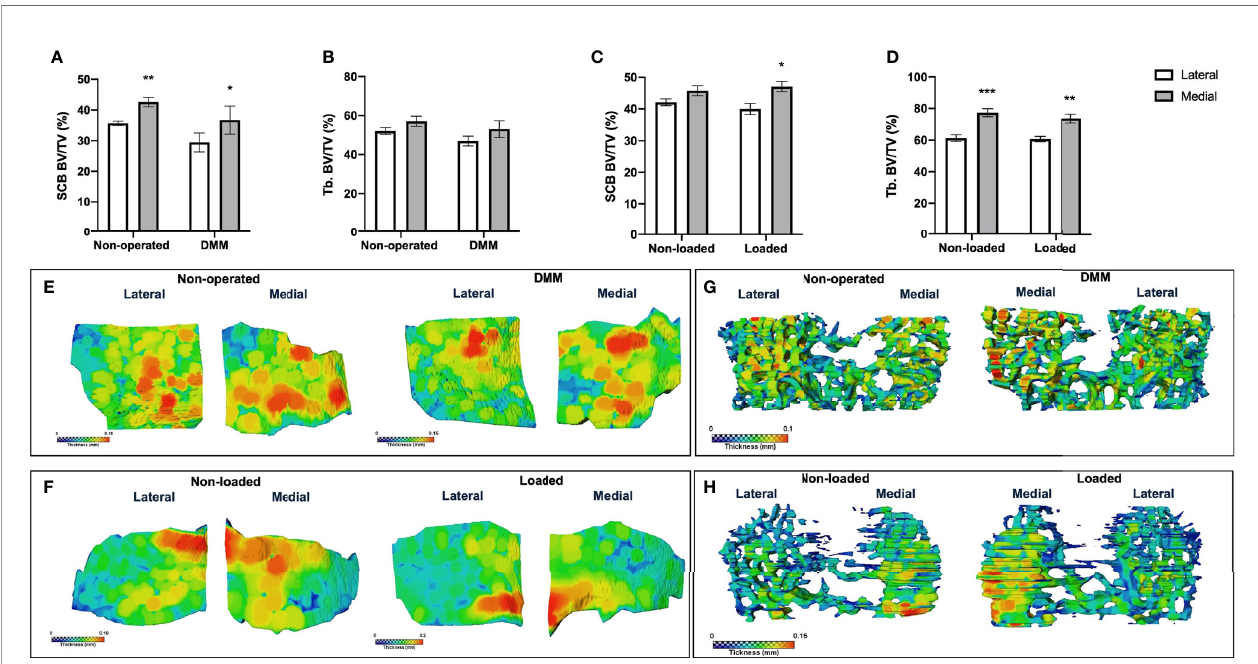
FIGURE 4 | MicroCT analysis of epiphyseal region of medial and lateral tibiae of mice. MicroCT analysis of the epiphyseal region of the lateral and medial tibiae in non-operated controls and DMM-operated knee joints subchondral bone volume fraction (SCB BV/TV) (A) and epiphyseal trabecular bone volume fraction (Tb. BV/ TV) (B) . MicroCT analysis of the epiphyseal region of the medial and lateral tibiae in non-loaded controls and loaded knee joints subchondral bone volume fraction (SCB BV/TV) (C) and epiphyseal trabecular bone volume fraction (Tb. BV/TV) (D) . Representative colour coded images of lateral and medial subchondral bone plate thickness of non-operated and DMM-operated tibiae of mice (E) . Representative colour coded images of lateral and medial subchondral bone plate thickness of non-loaded and loaded tibiae of mice (F) . Representative colour coded images of epiphyseal trabecular bone thickness of non-operated and DMM-operated (G) , or non-loaded and loaded tibiae of mice (H) . Bars represent mean ± SEM. Group sizes were n = 8 for non-operated and DMM-operated mice and n = 6 for non- loaded and loaded mice. * indicates differences between lateral and medial tibiae * p < 0.05 ** p < 0.01 *** p <